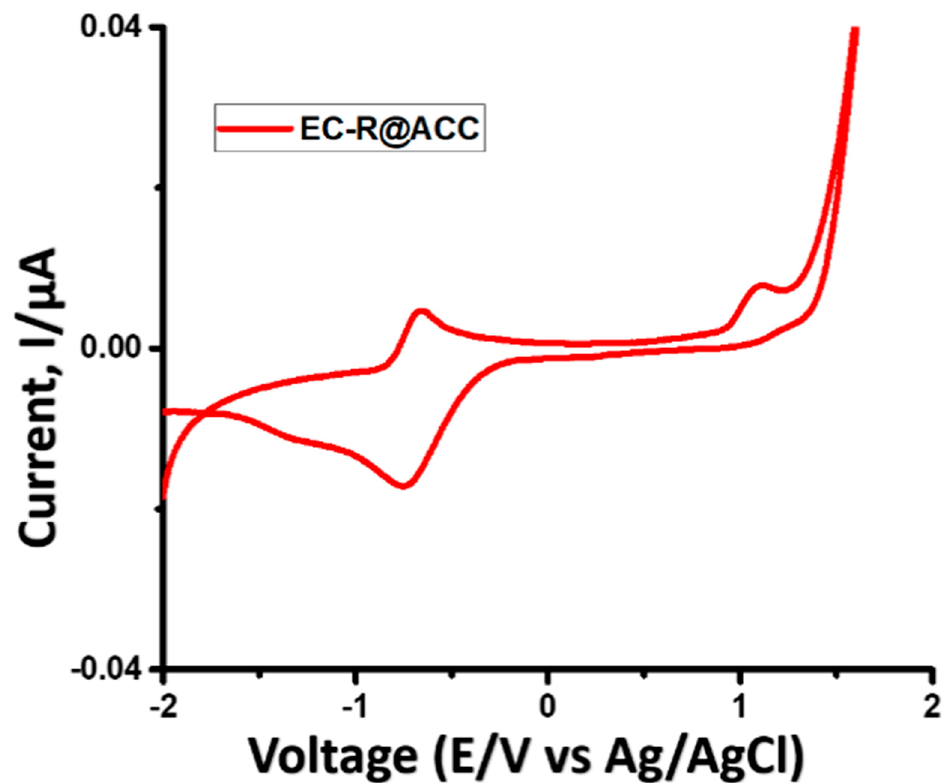
Figure 3. Cyclic voltammetry of the EC-R@ACC photocatalyst.